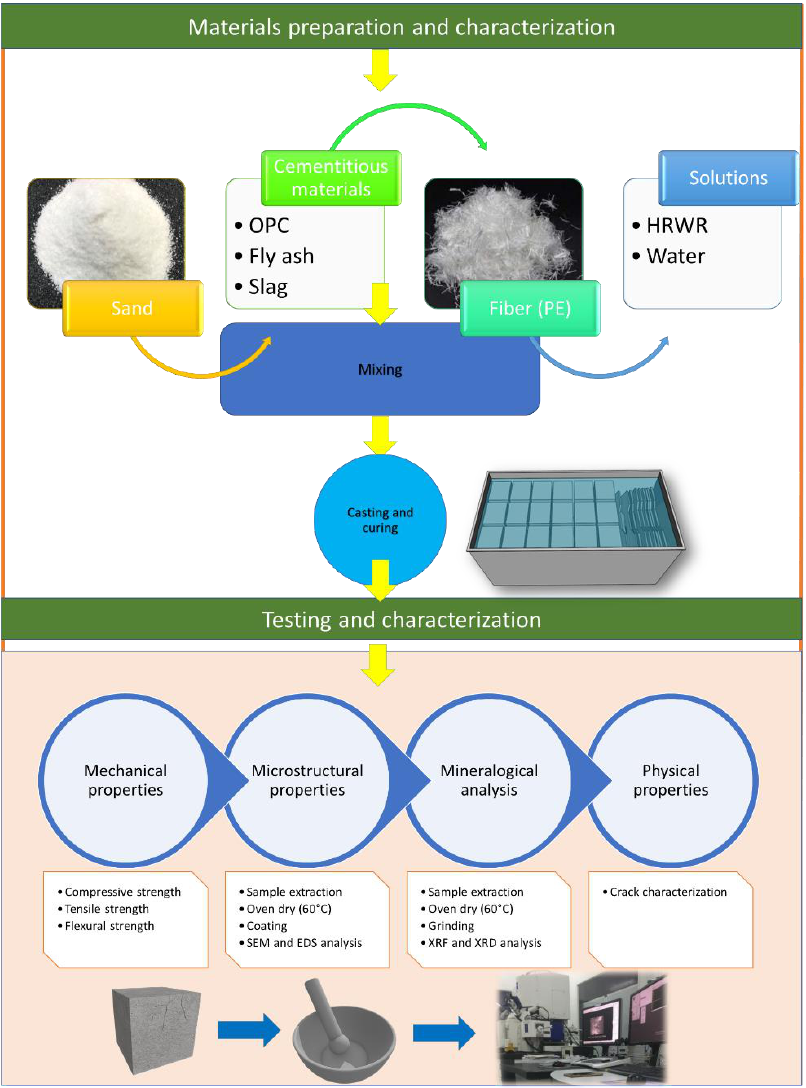
Figure 3. Overall flowchart of the methodology.